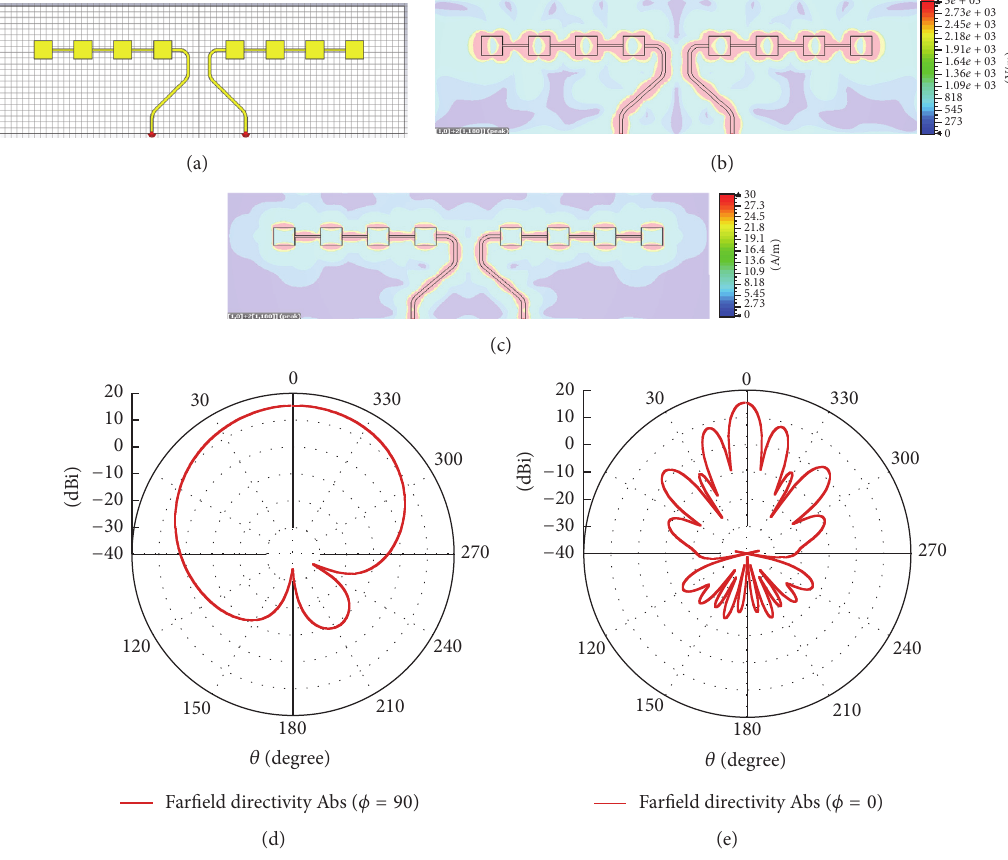
Figure 6: Transmitting antenna geometry (a); 𝐸 𝑧 field distribution (b) and 𝐻 𝑧 field distribution (c) on the patch plane; sagittal (d) and azimuthal (e) radiation